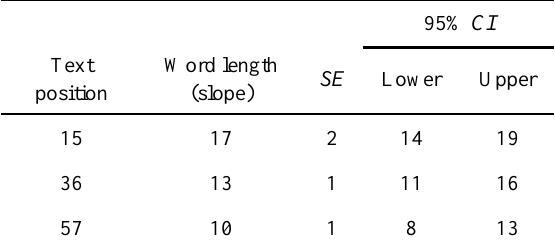
Table A5. Gaze duration: Interaction of word length and serial text position.